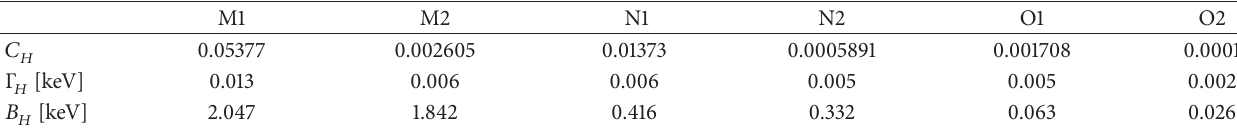
Table 1: Atomic parameters for electron capture in Holmium from shells M1 to O2. The values of 𝐶 𝐻 [56, 57] correspond to the atomic shells in Holmium, while the orbital electron widths Γ 𝐻 [58] and binding energies 𝐵 𝐻 ( < Q ) [59–61] correspond to the atomic shells in Dysprosium. M1 M2 N1 N2 O1 𝐶 𝐻